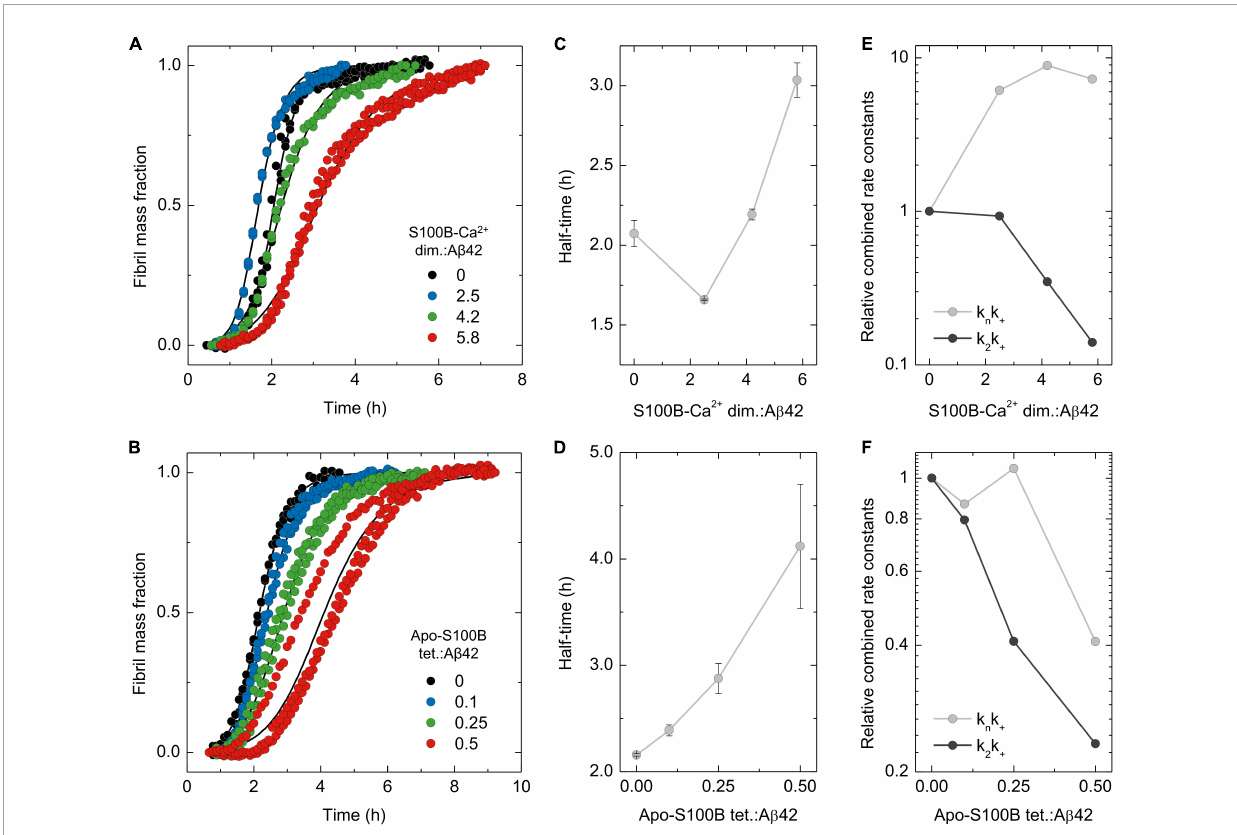
FIGURE1 Analysis of dimeric and tetrameric S100B effect over A β 42 aggregation mechanisms. Normalized traces of ThT-monitored aggregation of monomeric A β 42 [6 µ M in panel (A) or 2 µ M in panel (B) ] in the presence of increasing molar ratios of (A) S100B-Ca 2 + dimer:A β 42 (0–5.8) or (B) apo-S100B tetramer:A β 42 (0–0.5) with the (C,D) respective values of aggregation half-times (t 1 / 2 ). Solid lines depict global fits of each curve obtained by varying the rate constants of primary ( k n k + ) and secondary ( k 2 k + ) A β 42 aggregation pathways, with the relative values of each combined rate constant plotted as a function of S100B (E) dimer and (F) tetramer ratios. In all cases, error bars represent standard deviation of three